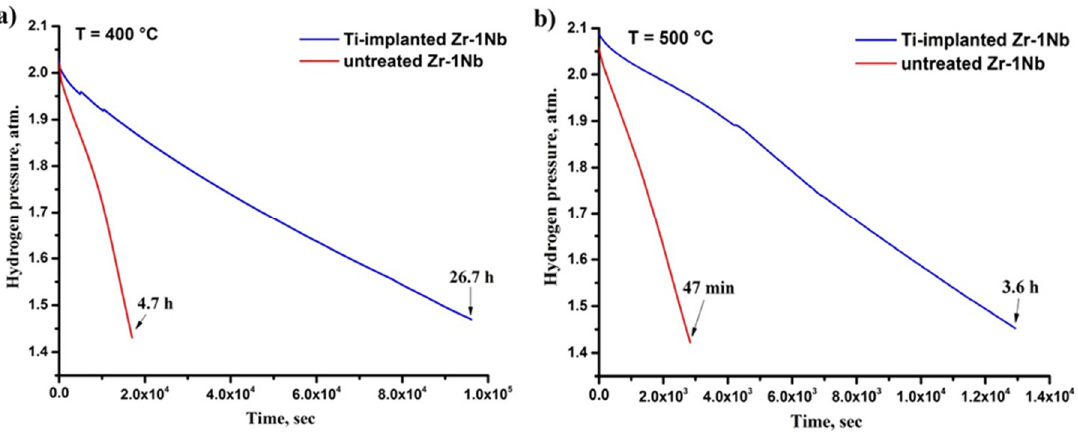
Figure 3. Hydrogen pick-up curves at ( a ) 400 ◦ C and ( b ) 500 ◦ C.